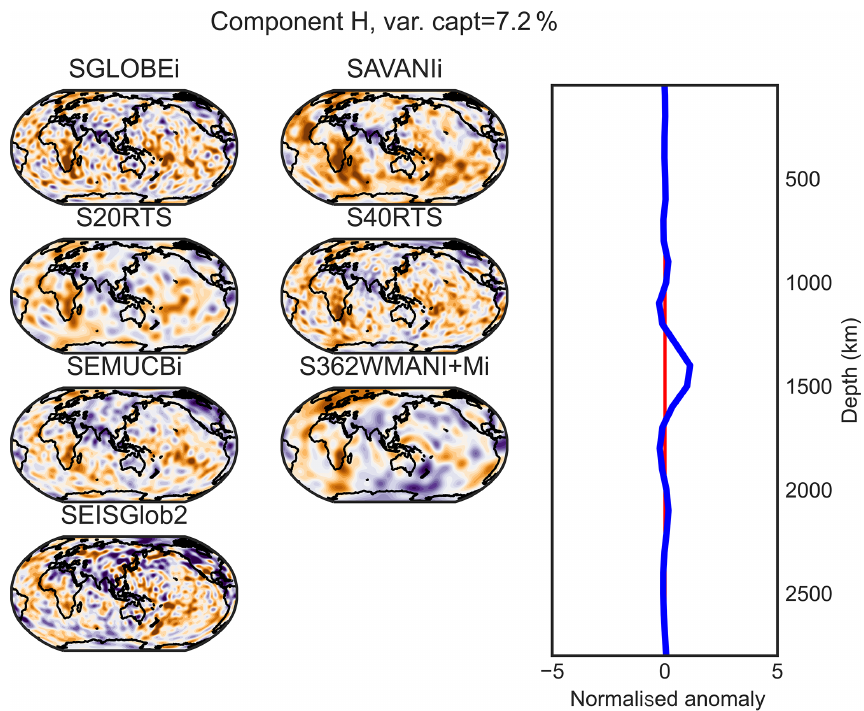
Figure D7. PC H (maximum at 1400km of depth) of the combined analysis of the isotropic parts of the models.